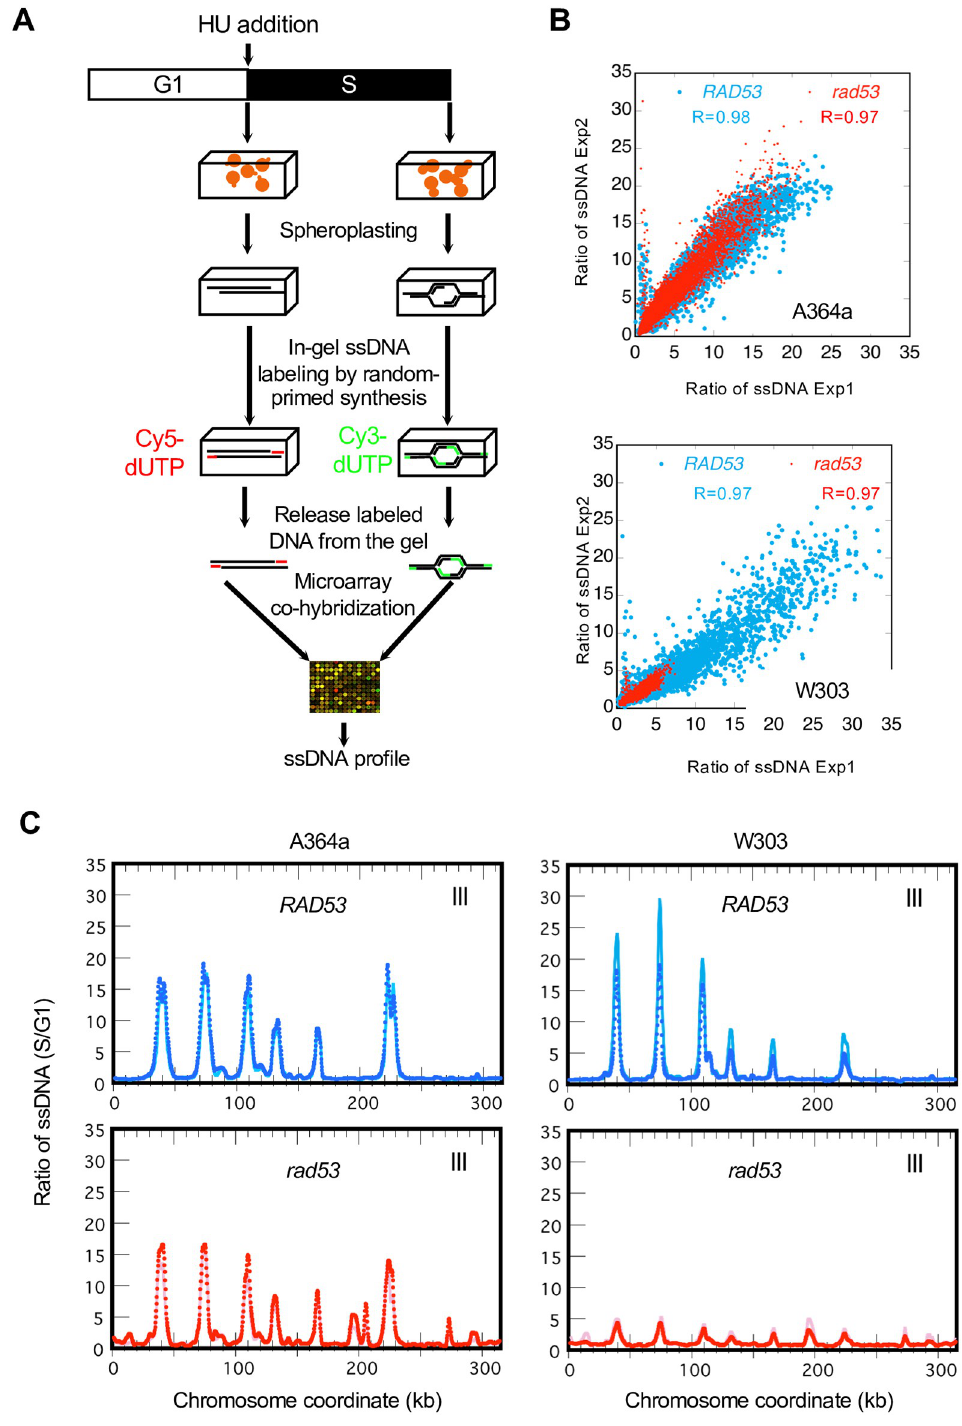
Fig 1. Genome-wide ssDNA mapping in two laboratory yeast strains. (A) Schematic experimental procedures of ssDNA mapping by microarray. ( B ) Reproducibility of ssDNA ratios (S/G1) from two independent experiments. Pearson correlation co-efficient values are shown. (C) Normalized ssDNA profiles of ChrIII (ssDNA ratios of S/G1 plotted against chromosome coordinates in kb) for RAD53 and rad53-K227A cells in the A364a (left) and the W303 (right) background from one of the two replicate experiments (Exp